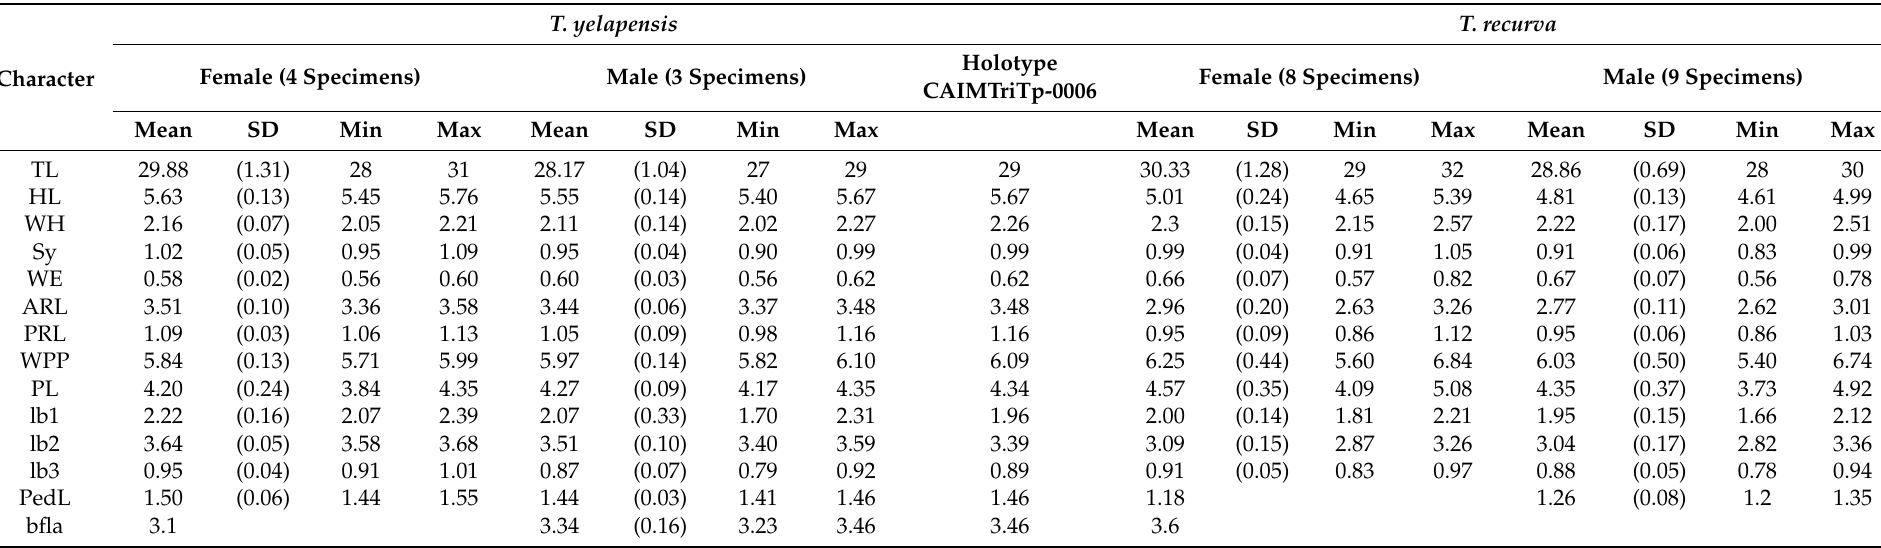
Table 1. Triatoma yelapensis character measures for females, males, the holotype and T. recurva (mm). ARL—length of anteocular region; bfla—length of basiflagellomere (the fourth was missing in all specimens); HL—length of head (excluding neck); lb1–lb3—length of first to third labial segments; Max = maximum value; Min = minimum value; PedL—length of pedicellus; PL—length of pronotum; PRL—length of postocular region; WE—width of eye; WH—width of